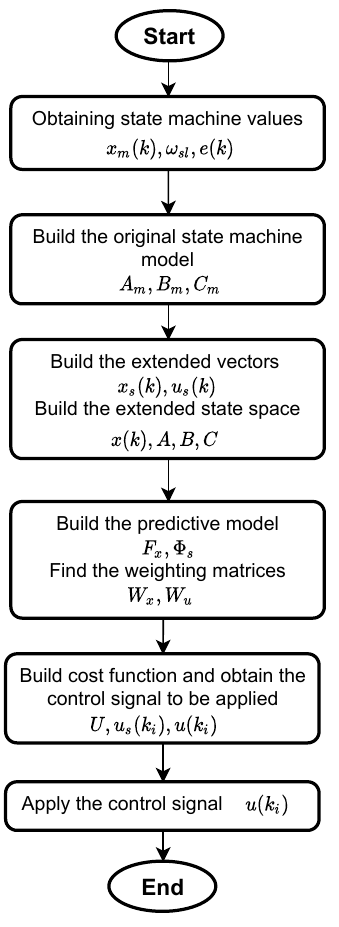
Figure 2. Repetitive-predictive control